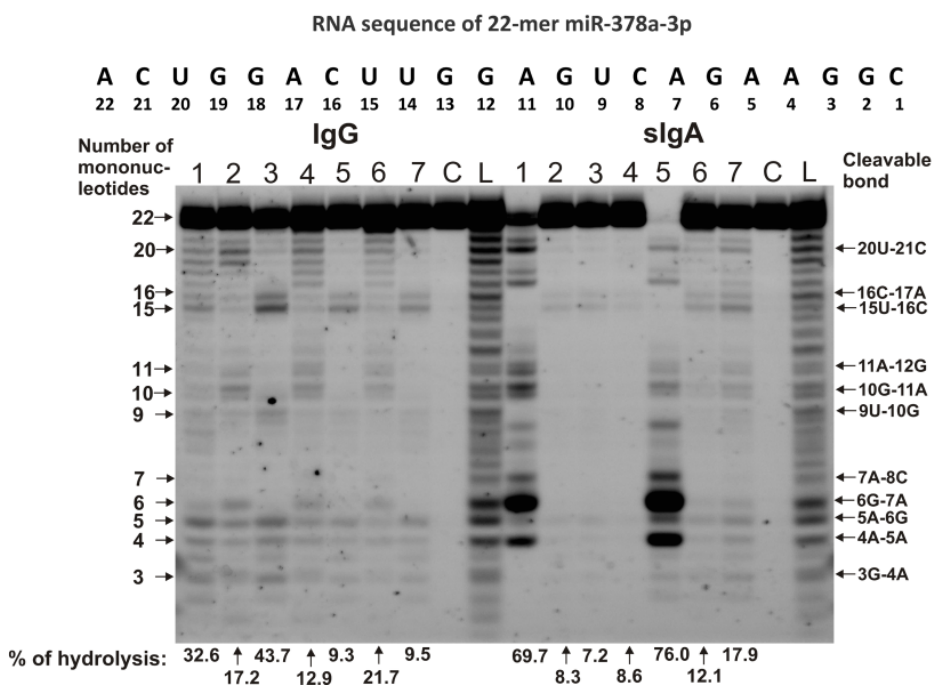
Figure 3. The patterns of 0.01 mg/mL Flu-miR-378a-3p hydrolysis by sIgAs and IgGs (0.04 mg/mL) from human milk plasma. The hydrolysis products were detected due to the fluorescent residue (Flu) on microRNAs’ 5 ′ -ends after reaction mixture incubation for 1 h. The numbers of sIgAs and IgGs, lengths of the splitting products, and the percentages of hydrolysis of microRNA by each antibody preparation, are indicated in the panel.